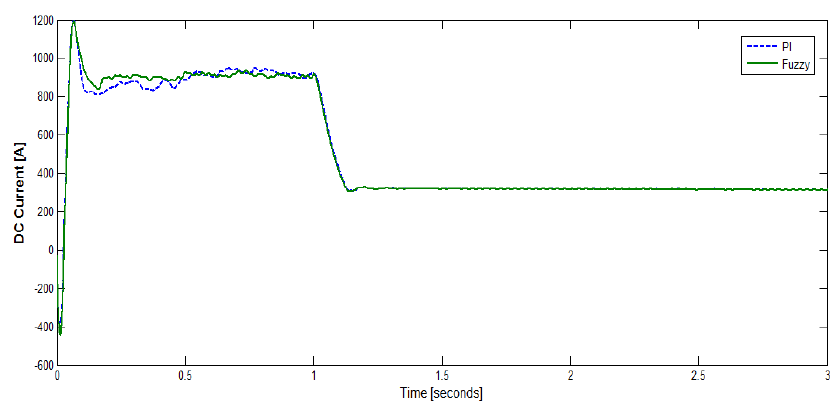
Figure 10. DC current waveform using fuzzy control.